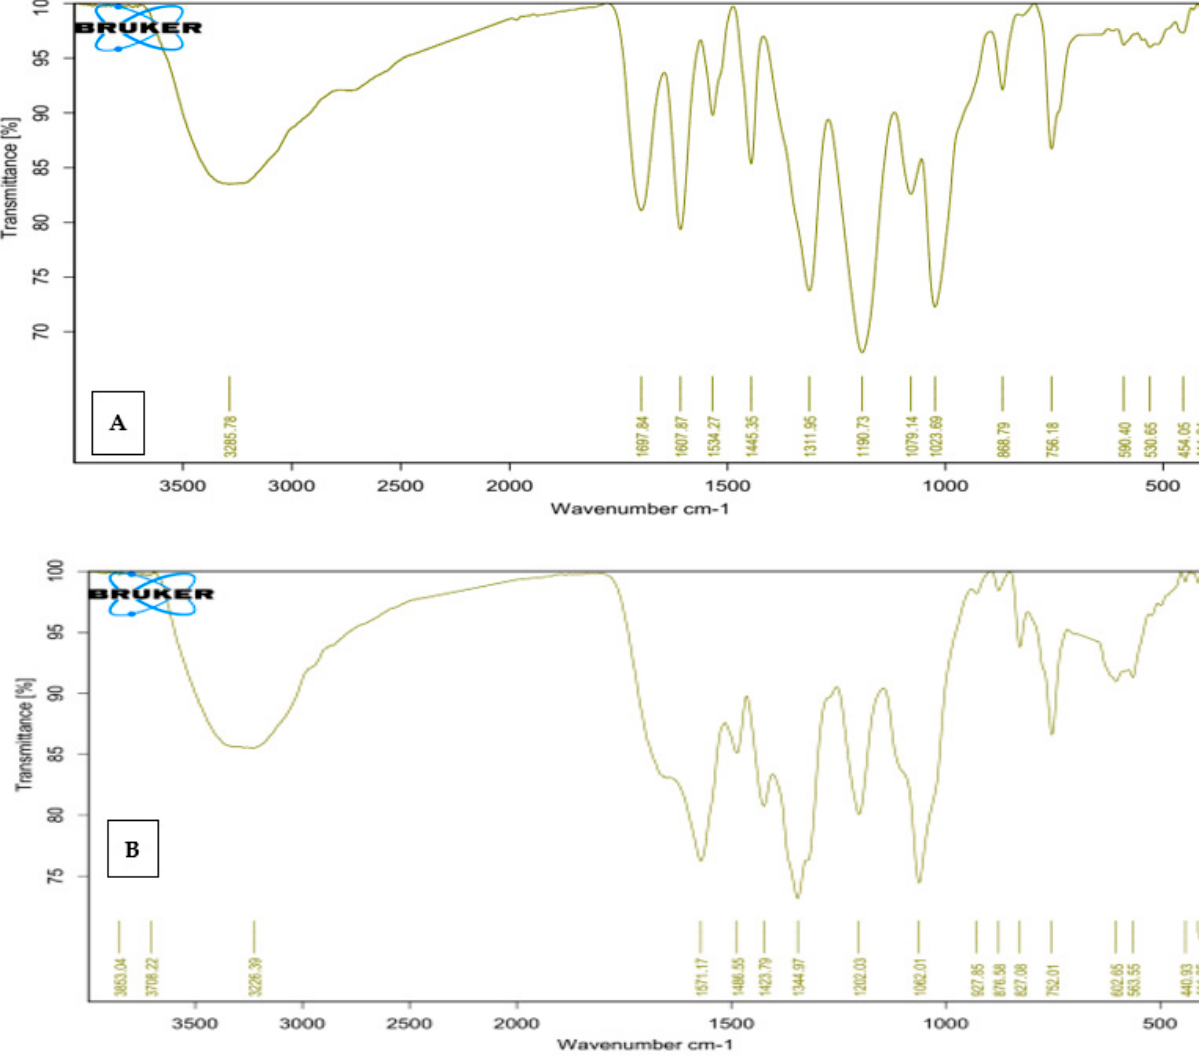
Figure 3. FT-IR spectra of Q.infectoria galls extract ( A ) and synthesized Qi-ZnO-NPs ( B ). FT-IR spectra (Figure 3B) confirm the synthesis of Qi-ZnONPs by the bending vibra- tions of Zn-O at 441 and 593 cm − 1 . The band in the region 3226 cm − 1 can be assigned to the